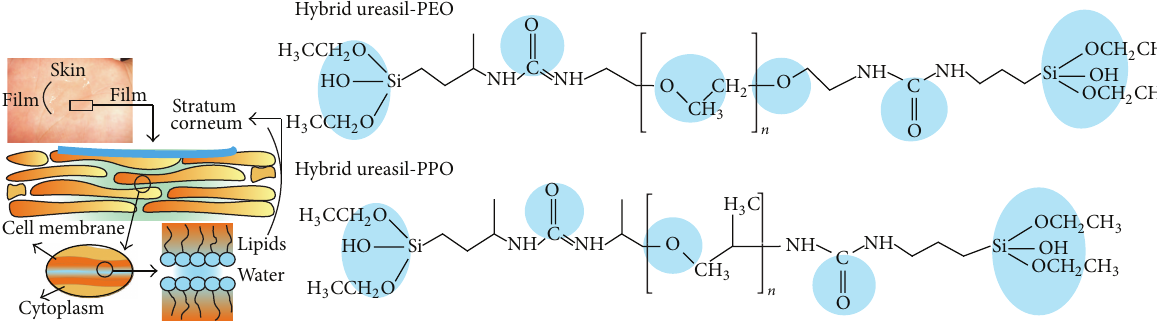
Figure 1: The structural formulas of the molecules of ureasil-PEO and ureasil-PPO hybrid materials and the possible sites of bonding with the biological substrate, highlighted in the blue